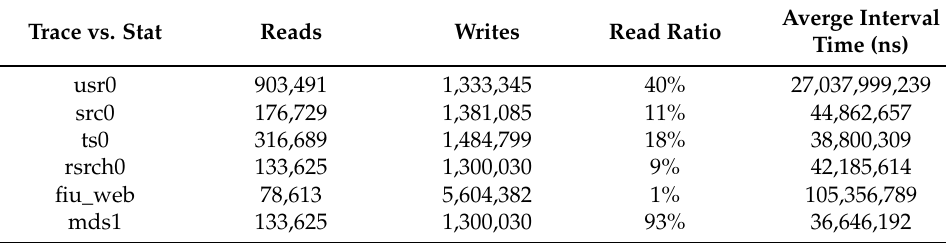
Table 2. Statistics of six real-world